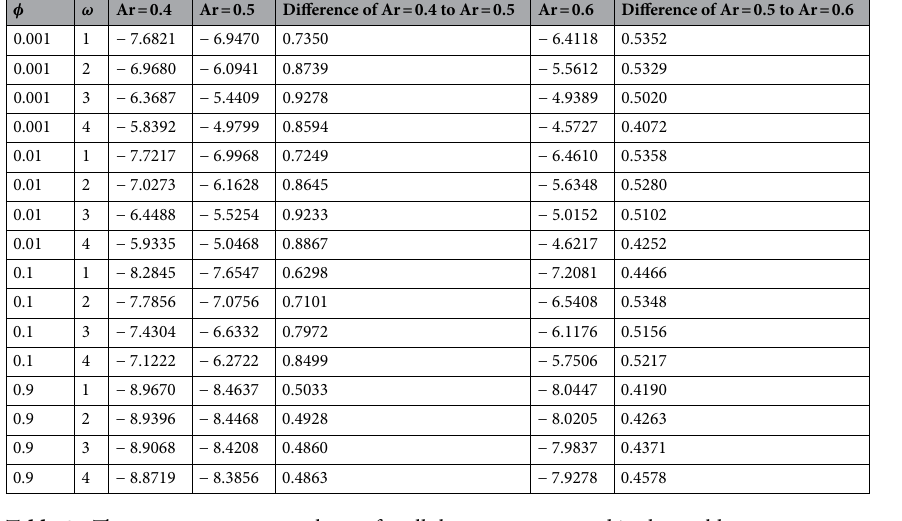
Table 4. The average percentage change for all the parameters used in the